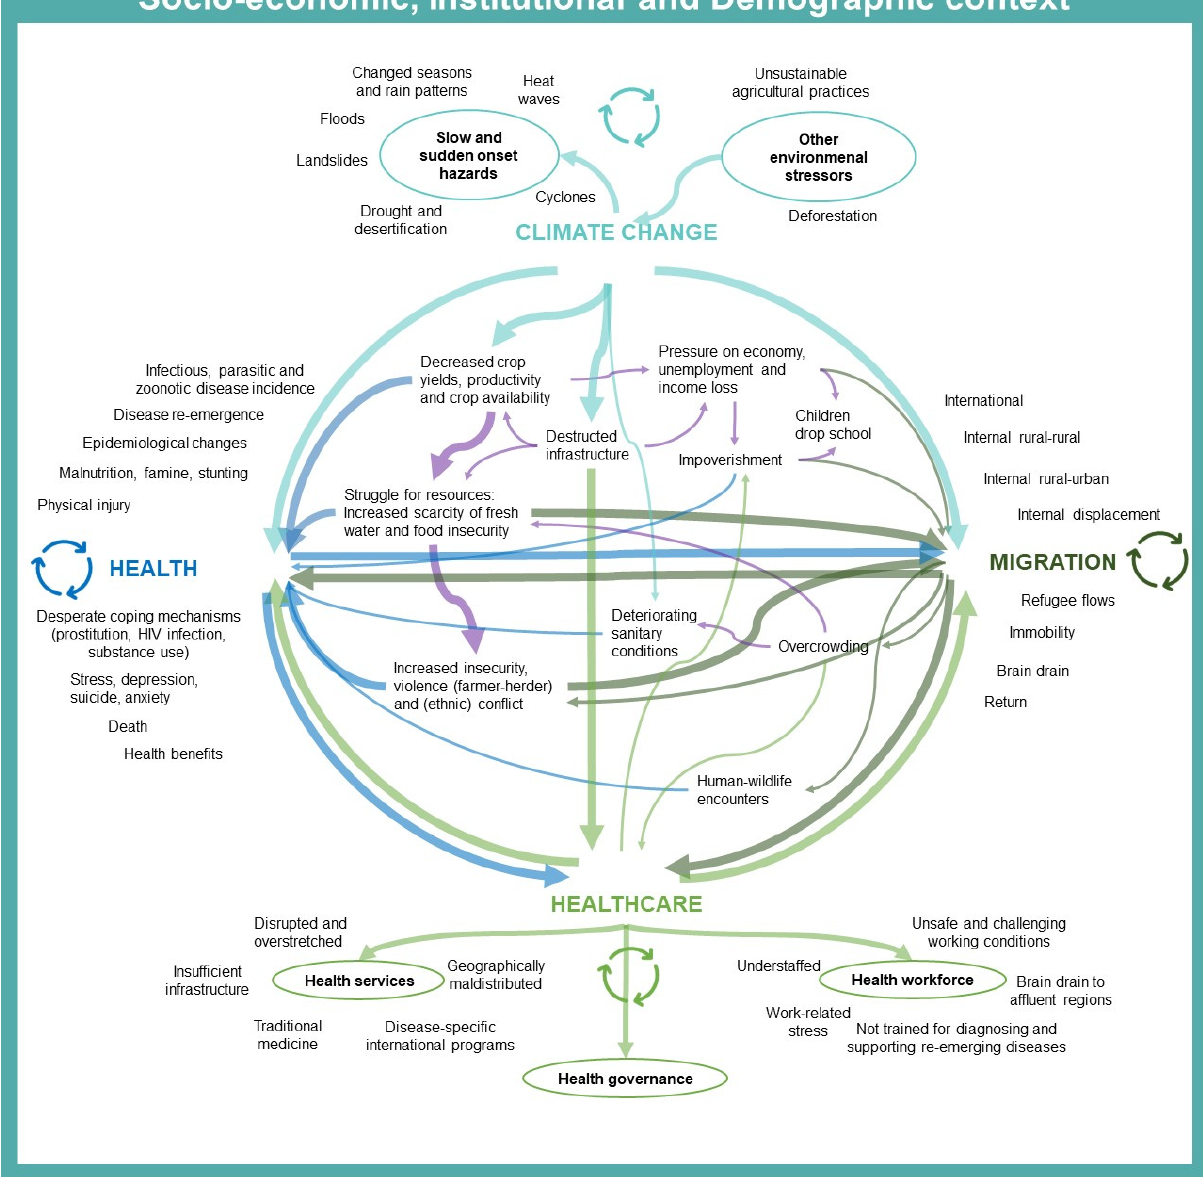
Figure 2. This diagram presents the authors’ interpretation of the participants’ perceptions regarding the climate change, migration, and health(care) nexus in Sub-Saharan Africa. The arrows in the center of the figure denote the direct and indirect interactions between the dimensions identified by the participants. These interactions reinforce each other, resulting in continuous feedback loops between both the nexus’s dimensions and the context-related determinants of health in the middle of the figure. Each arrow denotes a simple perceived impact and/or feedback loop interaction between two components corresponding to at least one participant statement. A sequence of arrows represents indirect interactions (hence a combination of direct interactions) running between interconnected components. The arrow’s thickness is proportionate to the number of quotes on the interactions, corresponding to at least one participant’s statement. The color represents the four dimensions of the nexus, with purple denoting other factors influencing the nexus. The loops denote feedback loops.